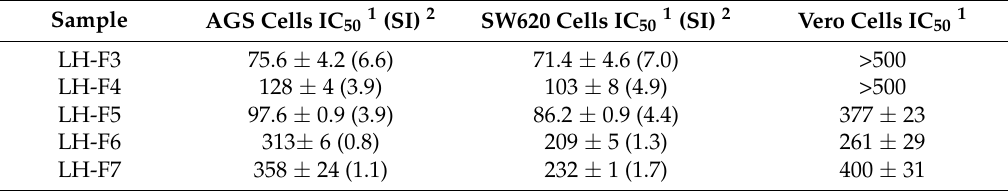
Table 3. Cytotoxicity of U. tomentosa fractions to gastric (AGS) and colon (SW620) adenocarcinoma cells, as well as to control Vero cells.